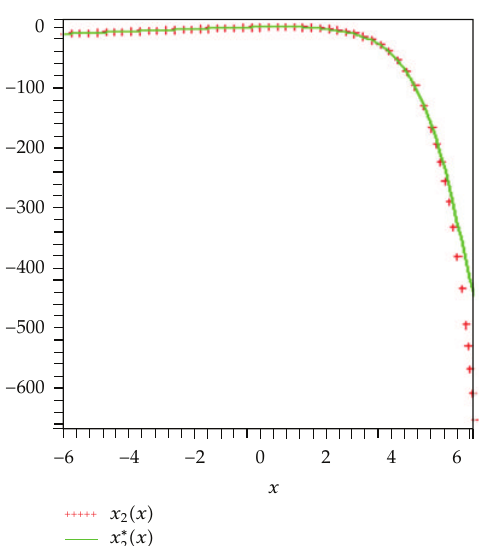
(cid:3) x (cid:4) variational iteration. 2